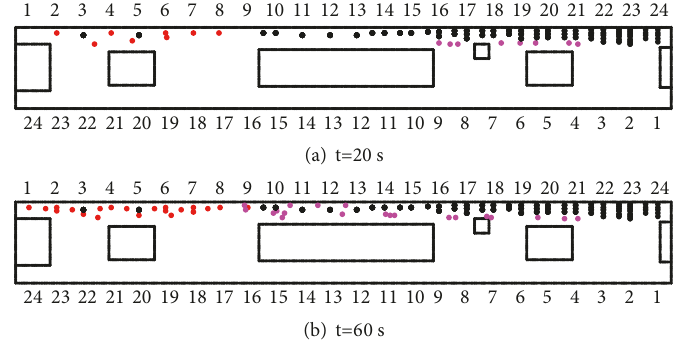
Figure 16: Illustration of 2D passenger distribution corresponding to a simulation during the model verification, t=20 s and t=60 s. Black circles stand for passengers left in the last cycle time.